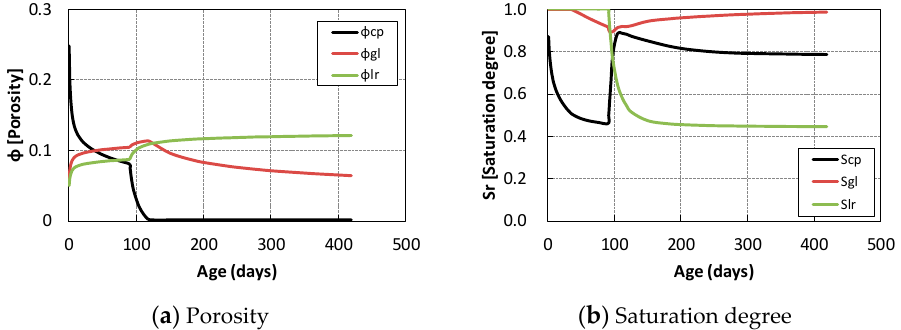
Figure 19. Numerical history of each porosity and saturation degree of capillary, gel and interlayer pores in the case of Figure 16d.